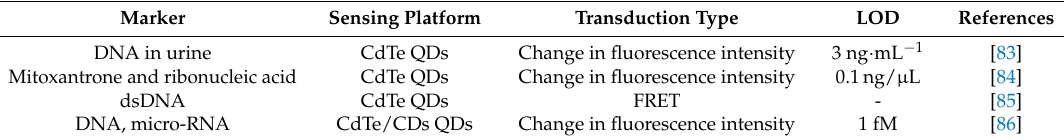
Table 5. QDs-based sensors for nucleic acids